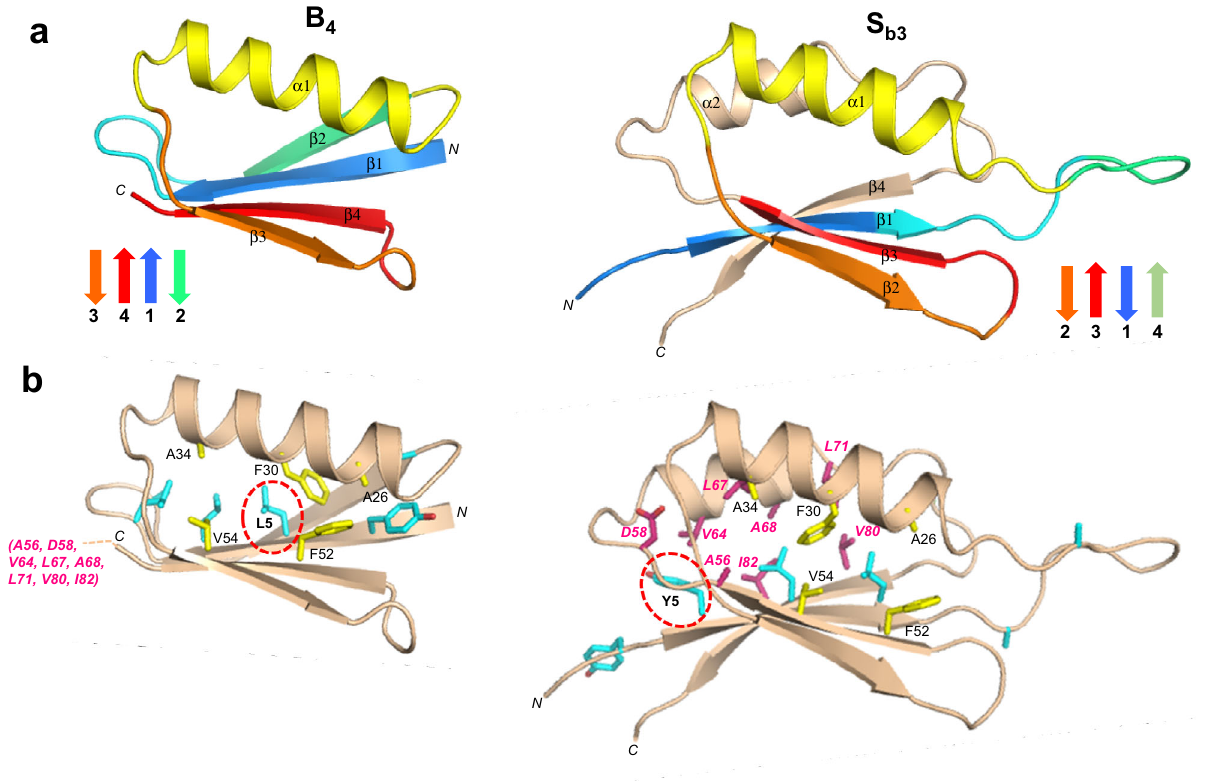
Fig.8|Structuraldifferencesinthehigh(~98%)sequenceidentityregionsofB 4 and S b3 . a Main chain comparisons. (Left panel) CS-Rosetta structure of B 4 with secondary structure elements color coded. (Right panel) Corresponding color- coded regions mapped onto the CS-Rosetta structure of S b3 , showing changes in backbone conformation. Regions outside the 56 amino acid sequence of B 4 are shown in wheat. b Side chain comparisons. (Left panel) Residues contributing to